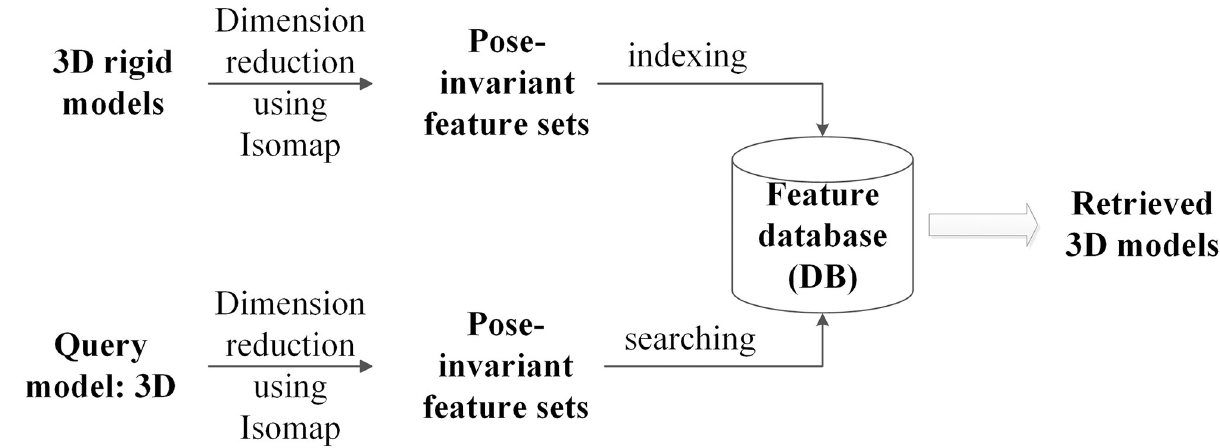
Fig 1. Overview of the 3D model retrieval process using our